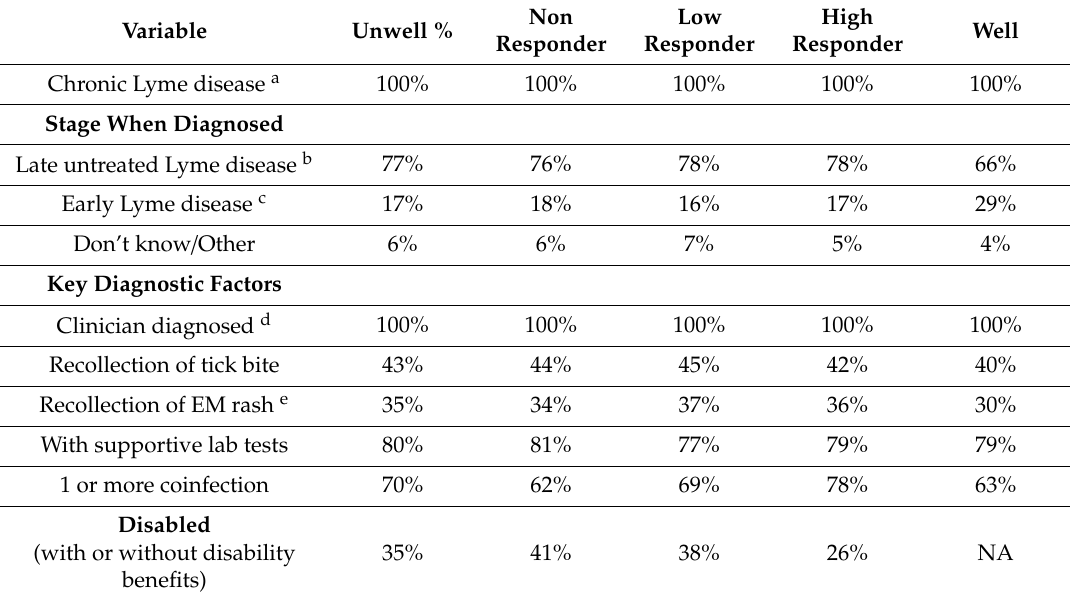
Table 1. Clinical and diagnostic characteristics of working